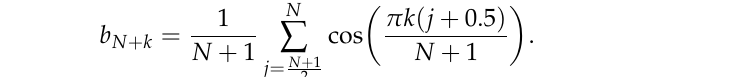
Figure 8. Frequency response in dB.